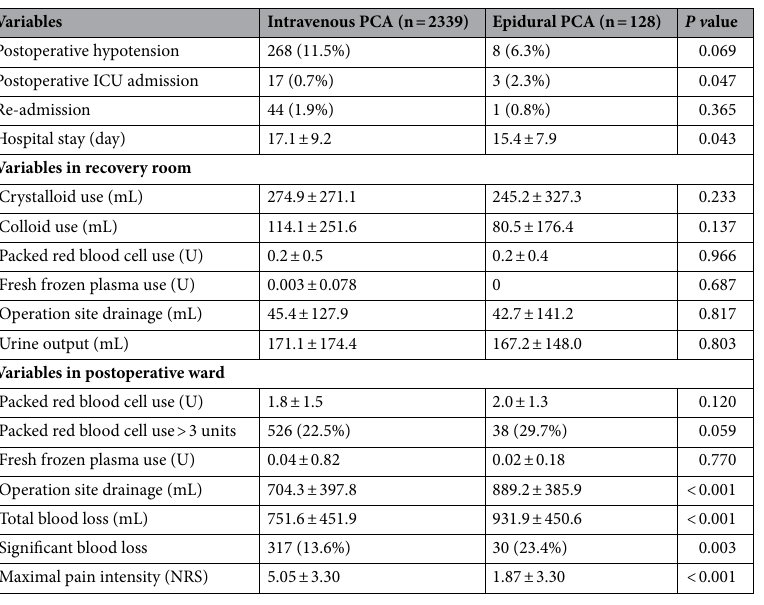
Table 3. Unmatched postoperative variables between the intravenous PCA and epidural PCA groups. Data are presented as mean ± standard deviation or number (%), as appropriate. PCA patient-controlled